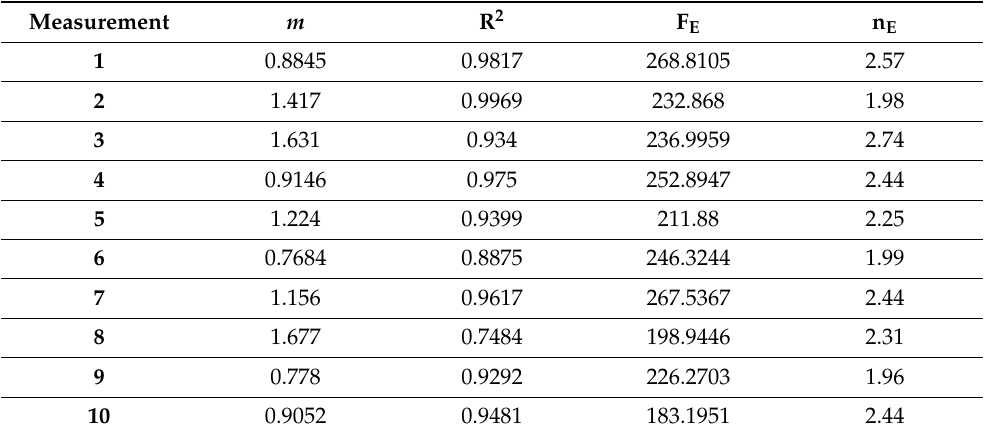
Table 5. Resulting parameters of the approximation curve.